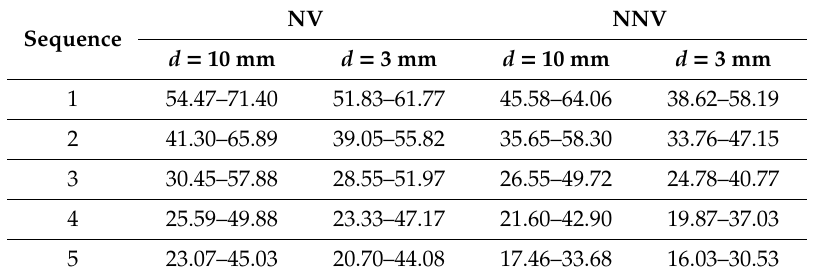
Table 9. Relative annual energy savings (%) of building B with PCM thickness of 3 mm or 10 mm.